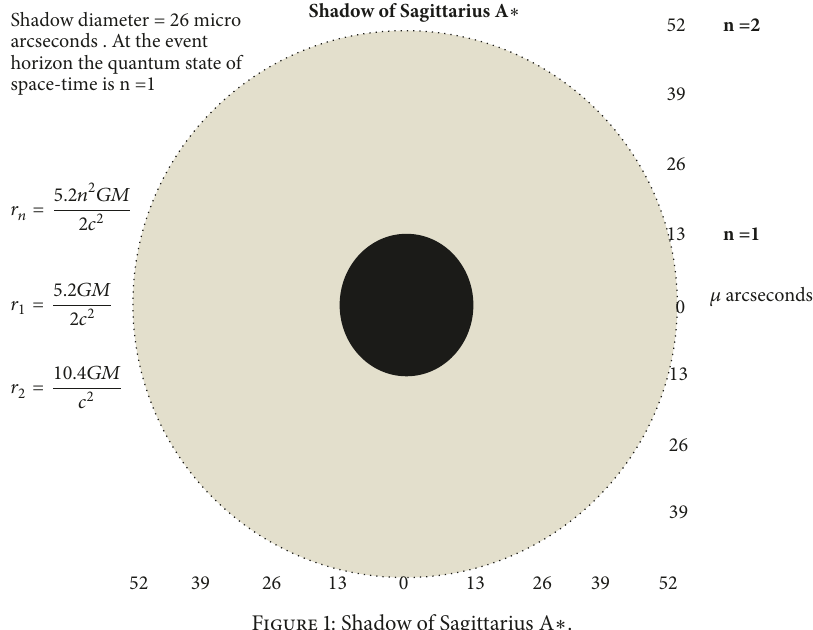
Figure 1: Shadow of Sagittarius A ∗